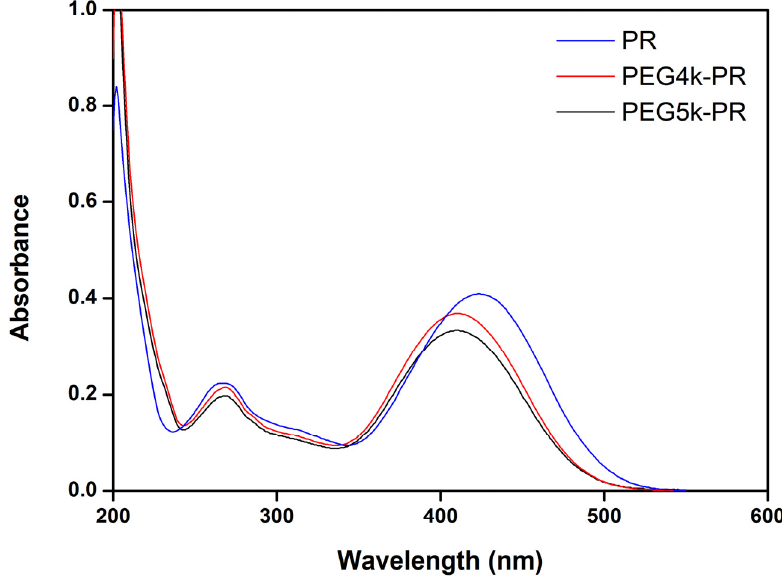
Figure 3. UV spectra of PR, PEG4k-PR, and PEG5k-PR.